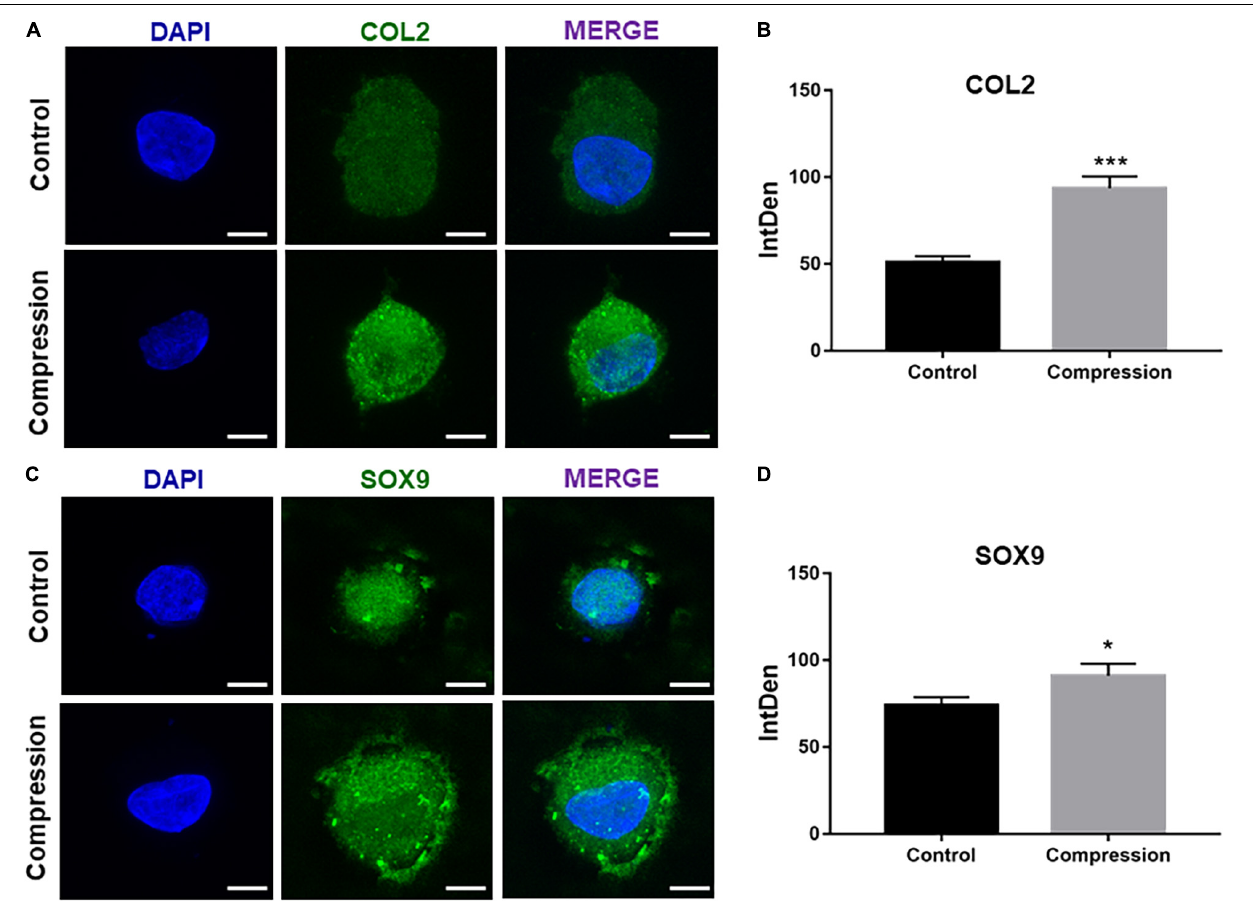
FIGURE 6 | (A,C) Immunofluorescence staining of COL2 and SOX9 after dynamic compression applied with preculture at day 28. Scale bars = 10 µ m. (B,D) Integrated density of COL2 and SOX9 by ImageJ. Results are presented as the mean ± S.D. * P < 0.05, *** p < 0.001. COL2, collagen type II; SOX9, SRY-box transcription factor